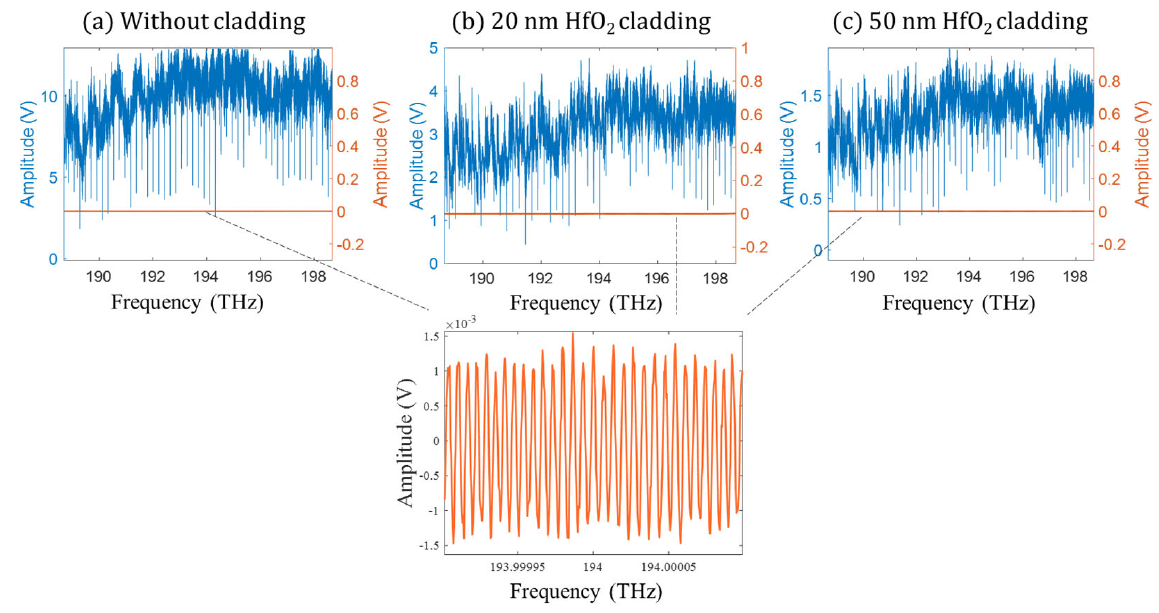
Figure 5. Transmission spectra and interference fringes of the ( a ) air-cladded, ( b ) 20 nm, and ( c ) 50 nm ALD-cladded devices.